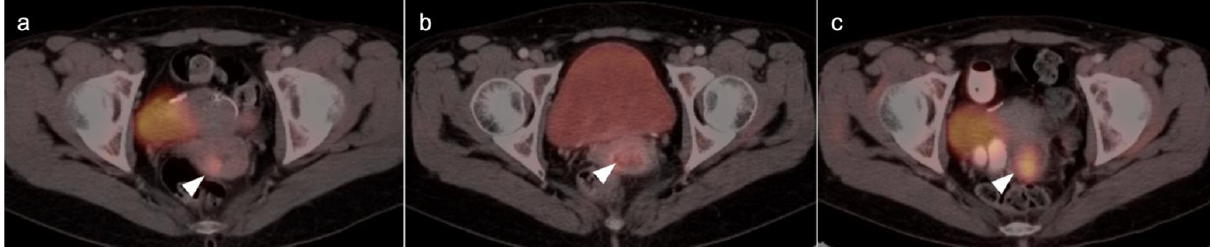
Figure 15. Stage IB1 cervical cancer shown on axial FDG PET-CT images of the pelvis. ( a ) Small cervical cancer (1.8 cm diameter, white arrowhead); ( b ) post radiation with persistent metabolic activity in the endocervix consistent with post-treatment inflammation vs. persistent tumor (white arrowhead); ( c ) 2 years later, cervical cancer recurred with a larger tumor (white arrowhead).